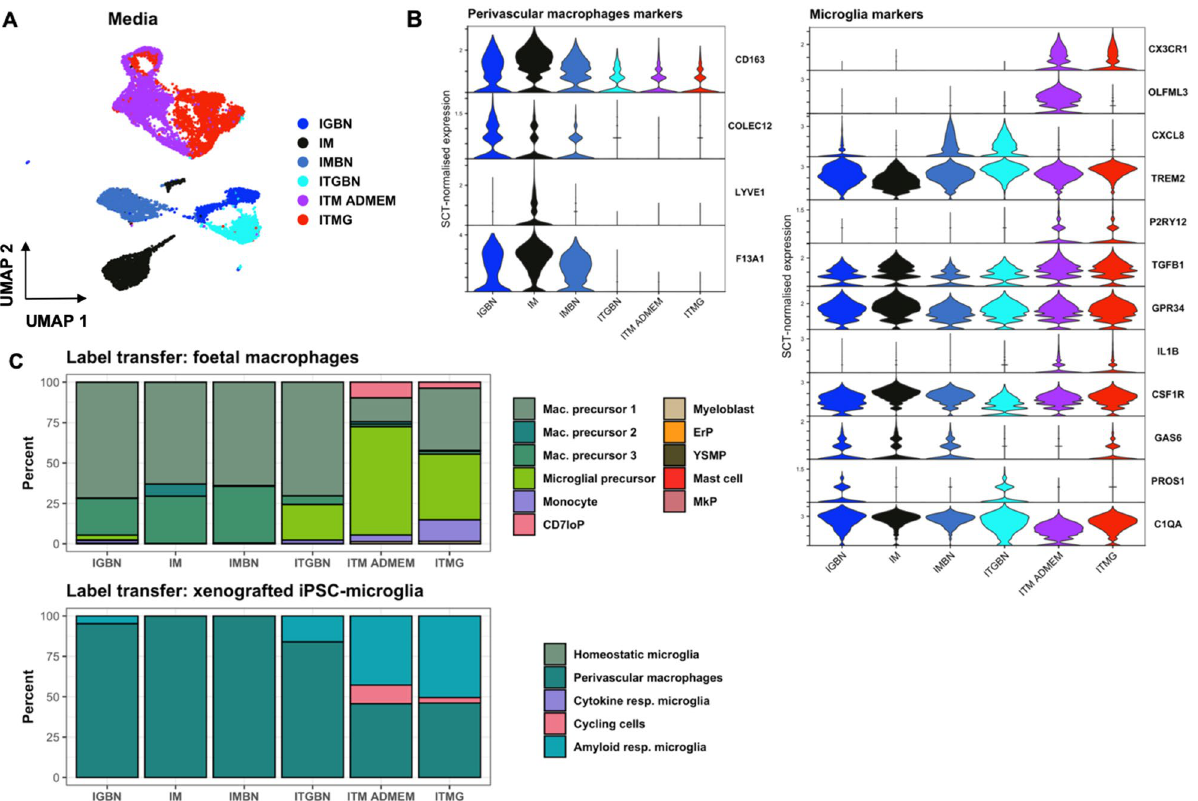
Figure 5. Single cell RNA-seq confirms that TGF-β1 promotes microglial identity. ( A ) Uniform manifold approximation and projection (UMAP) plot of quality-controlled iPSC-derived microglia cells, coloured by differentiation media. ( B ) Violin plots of SCT-normalised expression (y-axis) per media (x-axis) per perivascular macrophage or microglia marker gene. ( C ) Label transfer with singleR: cumulative percentage of cells (y-axis) of each label (colour) per media (x-axis). Mac precursor 1–3; macrophage precursors subtypes, CD7loP CD7lo progenitor, ErP erythroid progenitor, YSMP yolk sac-derived myeloid-biased progenitor, MkP megakaryocyte progenitor, Cytokine/Amyloid resp. microglia Cytokine/Amyloid response